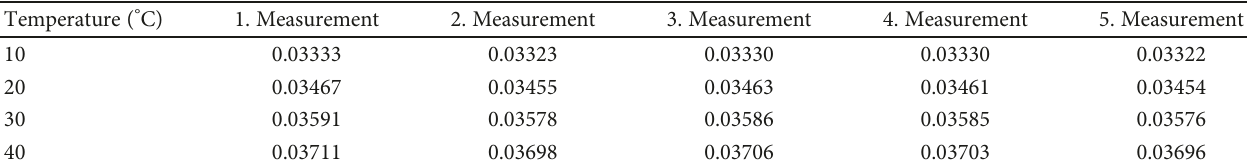
Table 3: Experimental results for density of 16 kg/m 3 .